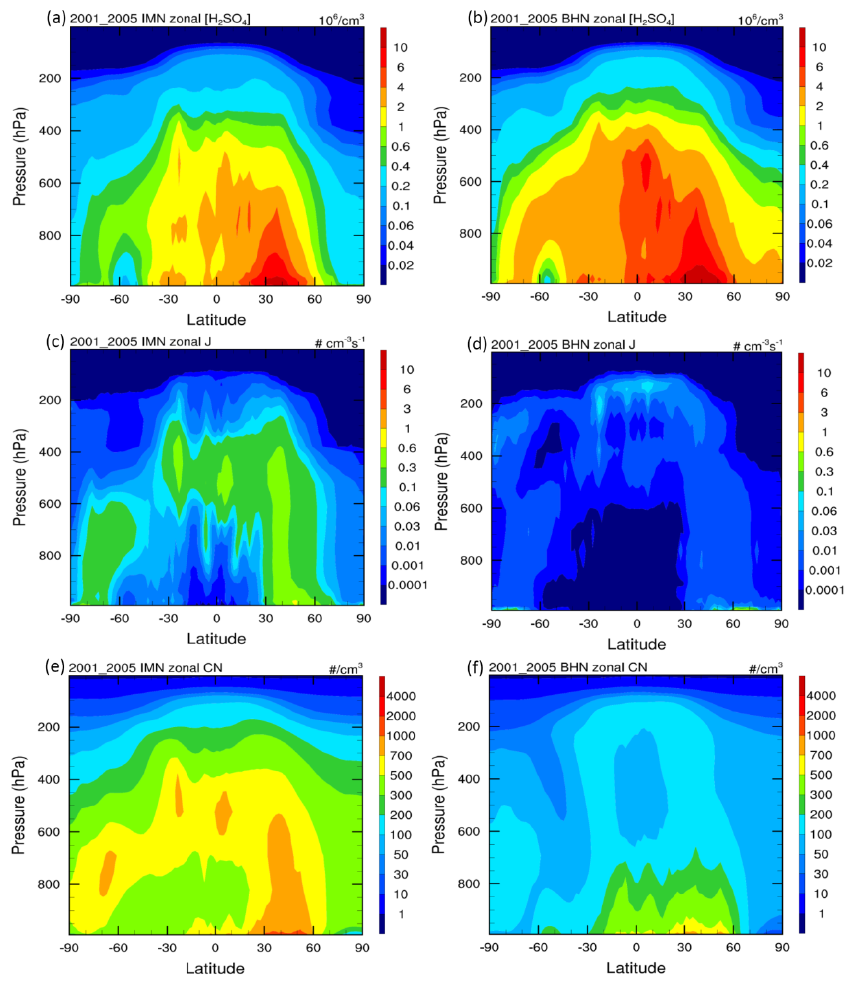
Figure 2. Fig. 2. Annual mean zonally averaged values of H 2 SO 4 vapor concentration, nucleation rate ( J ), and total condensation nuclei (CN) number concentrations based on IMN (a, c, e) and BHN (b, d, f)